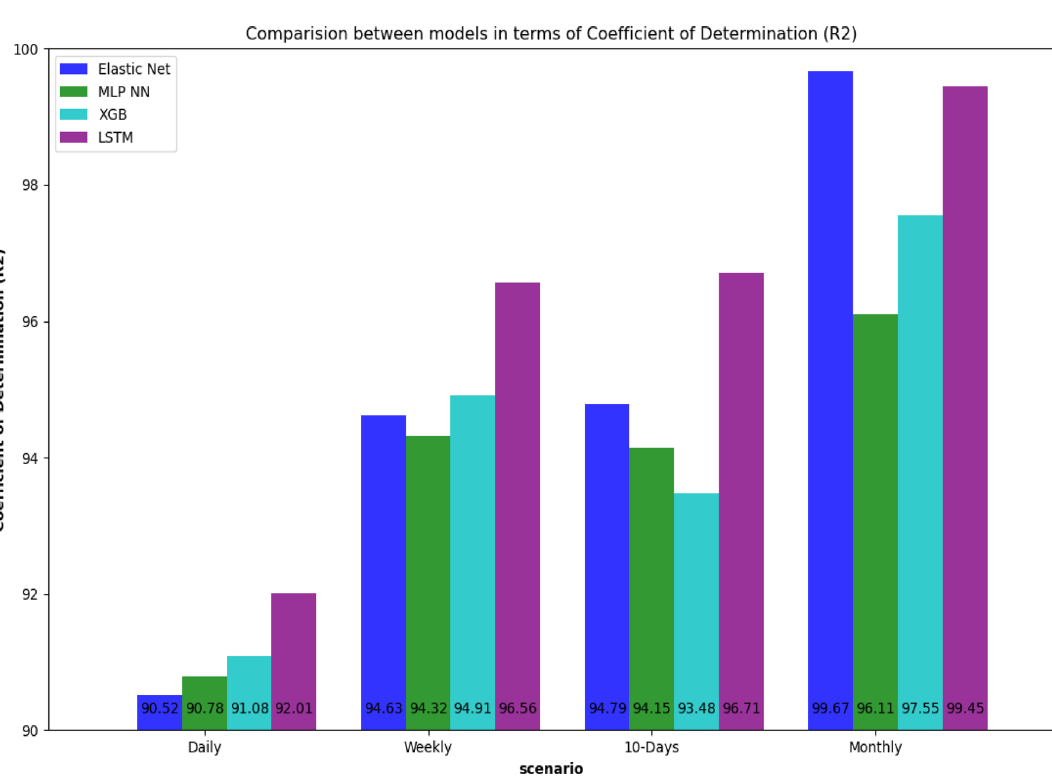
Figure 10. Coefficient of determination for four scenarios: daily, weekly, 10-days, monthly for four models: Elastic Net, MLP NN, XGB, and